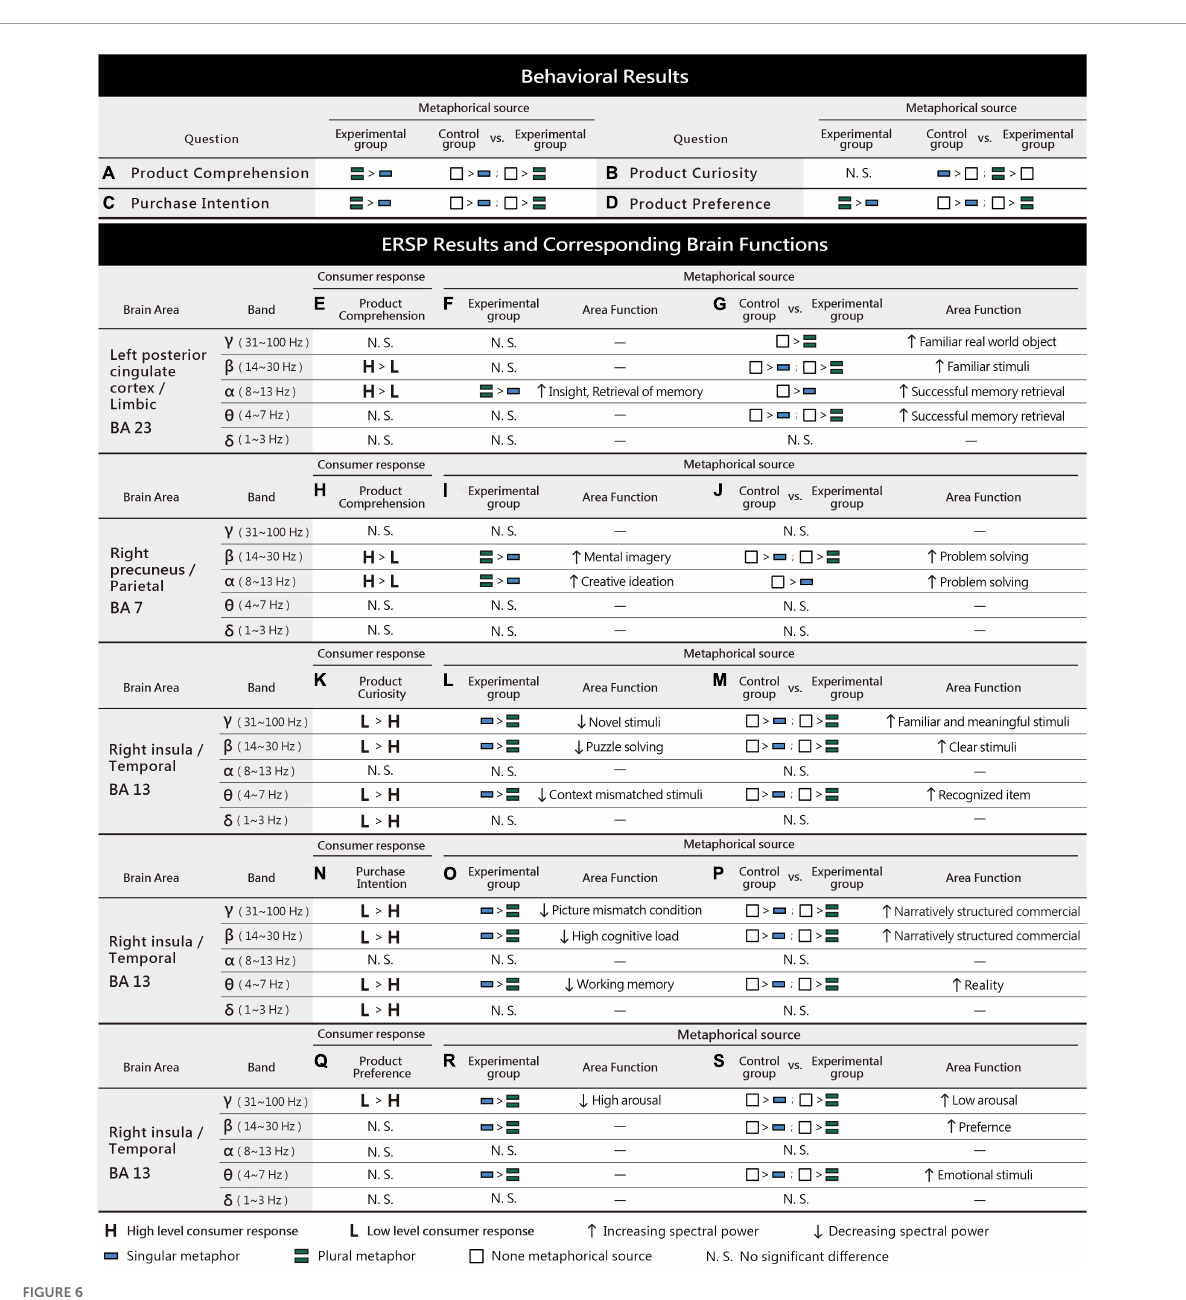
power in the left PCC ( Figures 6E,F ). Behavioral results revealed that the product comprehension of the plural metaphorical sources group was higher than that of the singular metaphorical source group ( Figure 6A ). The PCC is part of the limbic system (Leech and Sharp, 2014), and the functions of the left PCC are associated with insight (Jung-Beeman et al., 2004). Insight refers to a type of sudden understanding, which encompasses the swift comprehension of a metaphor or the sudden recognition